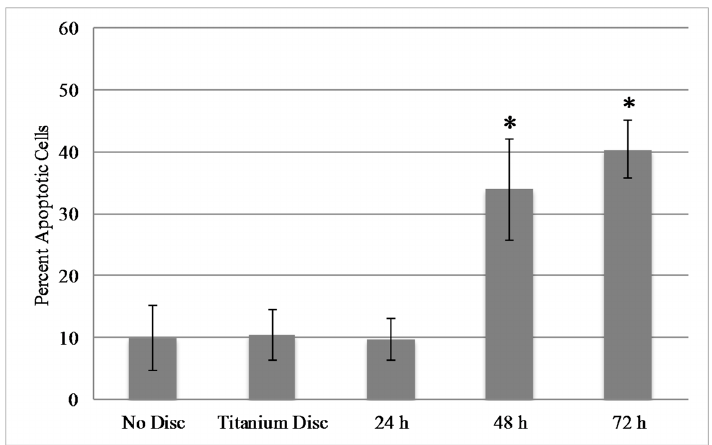
Figure 7. Mammalian in vitro toxicity assays. NIH3T3 (1.5 × 10 6 cells) were plated and cultured for approximately 12 h. Discs were then added for the indicated time points. Cells were collected and stained with Annexin-V and PI and flow cytometric analysis was performed. Assays were performed in triplicate and the averages are graphed with standard deviations. * p -value <0.05.